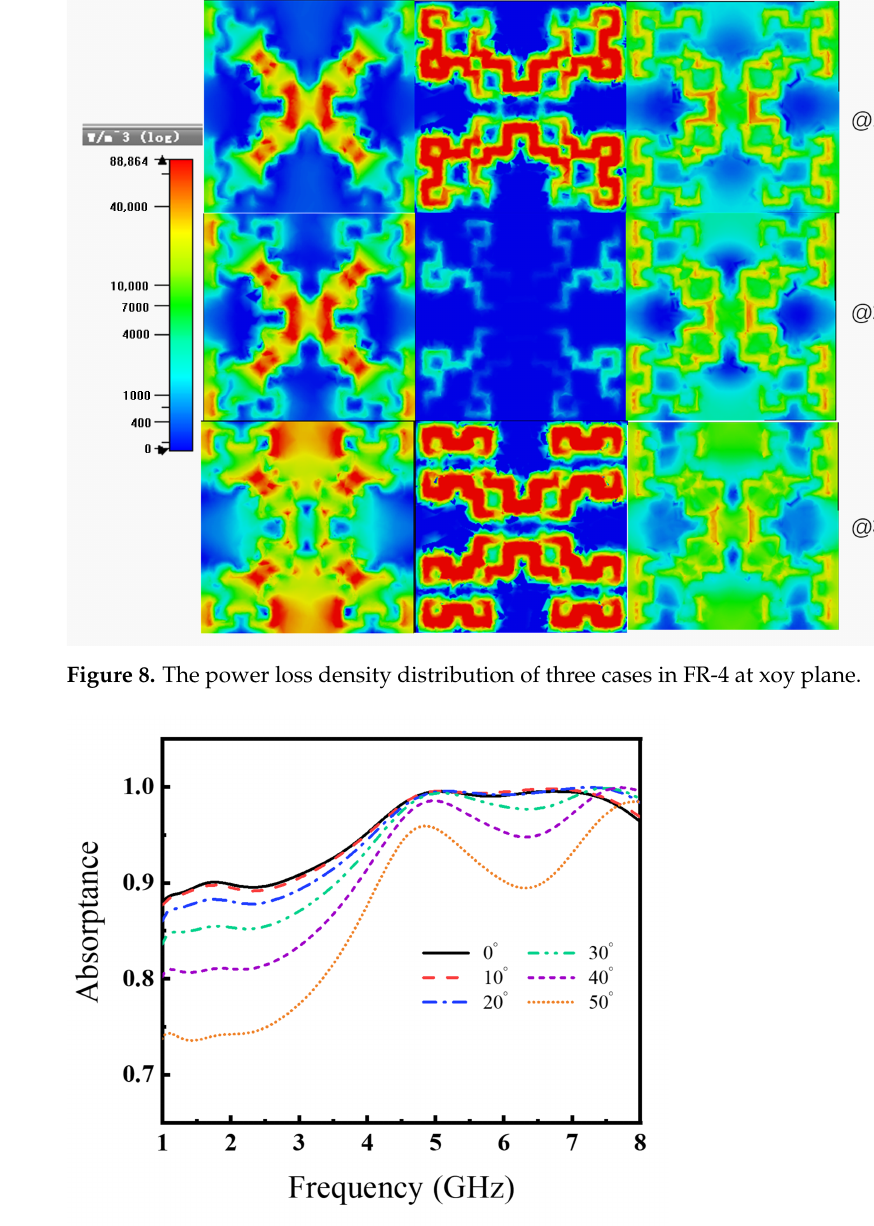
Figure 9. The absorptance at different incident